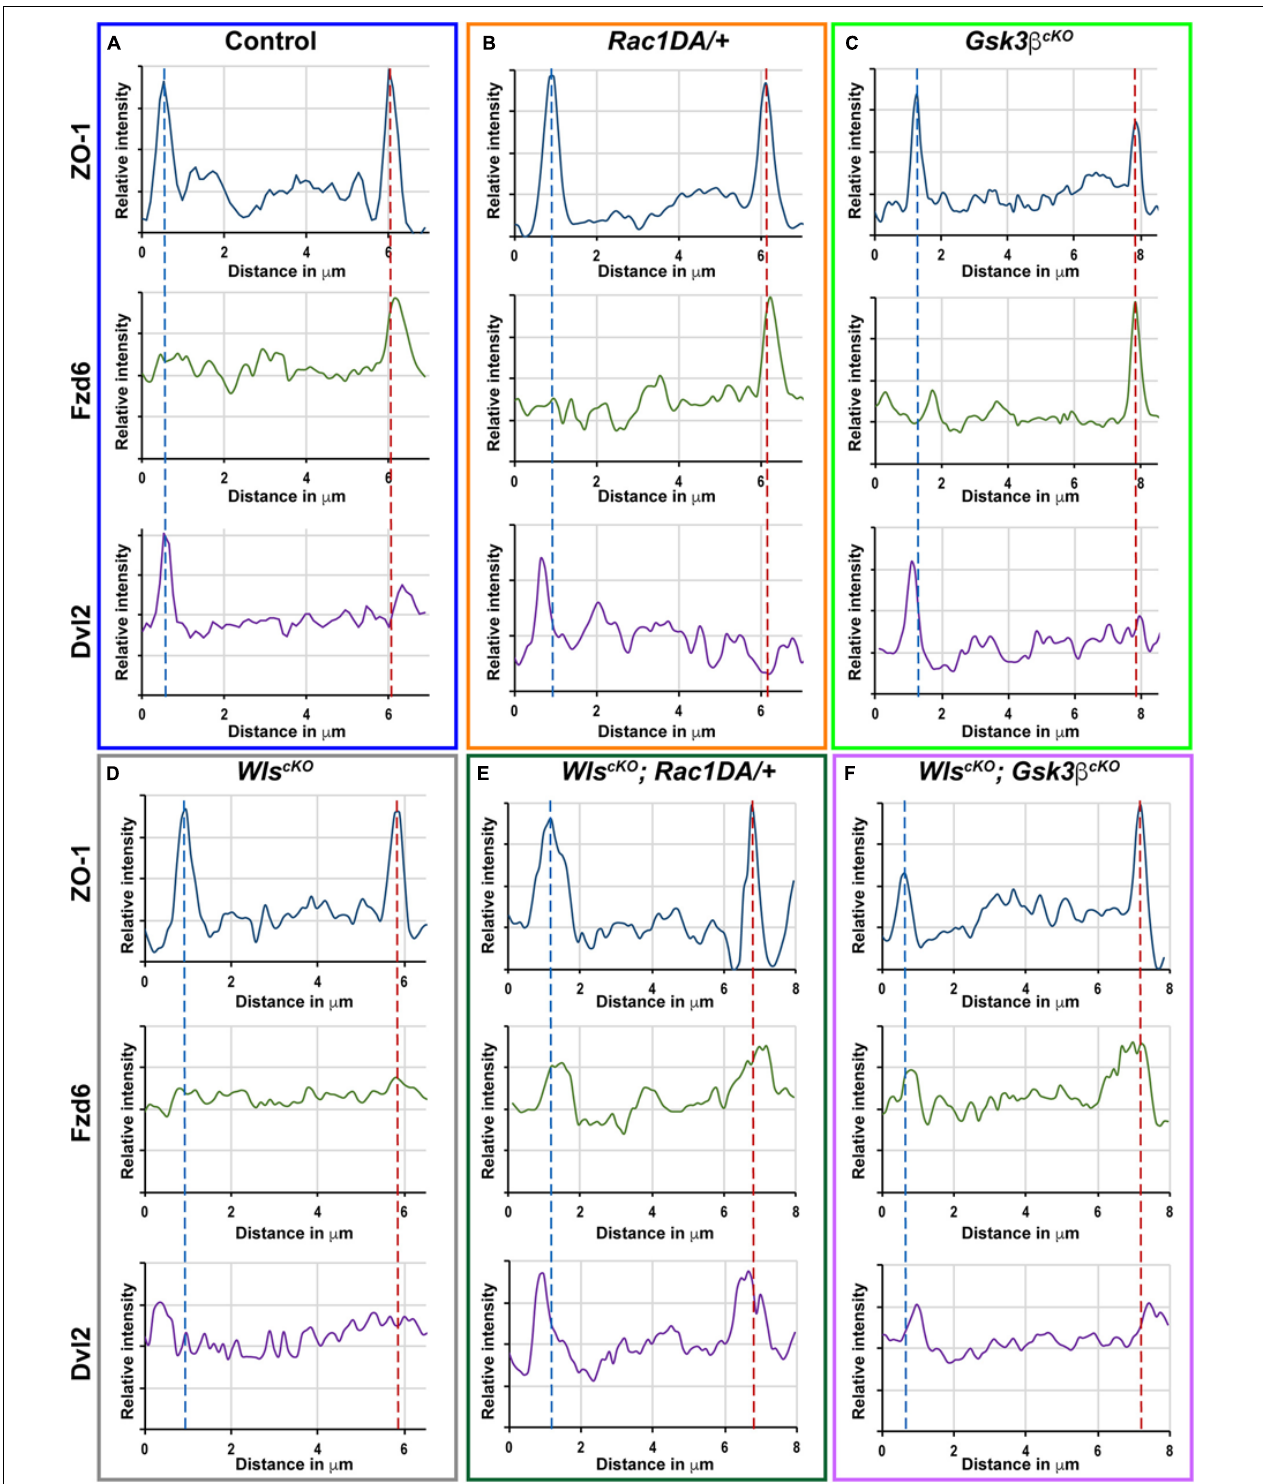
FIGURE 7 | Linescan analysis of junctional localization of Fzd6 and Dvl2 in outer hair cells. (A–F) Representative linescans of individual OHCs from E18.5 wild-type control (A) , Rac1DA/ + (B) , Gsk3 β cKO (C) , Wls cKO (D) , Wls cKO ; Rac1DA/ + (E) , and Wls cKO ; Gsk3 β cKO (F) OC stained for ZO-1, Fzd6, and Dvl2. For each genotype, a line was drawn parallel to the medial–lateral axis bisecting the OHC. Intensity profiles of each image channel were aligned along the distance axis. The lateral and medial junctions of the OHC were identified by peaks of ZO-1 staining and indicated by the blue and red dashed lines, respectively. Junctional Fzd6 and Dvl2 staining was defined by peaks in close proximity to the lateral or medial borders of the